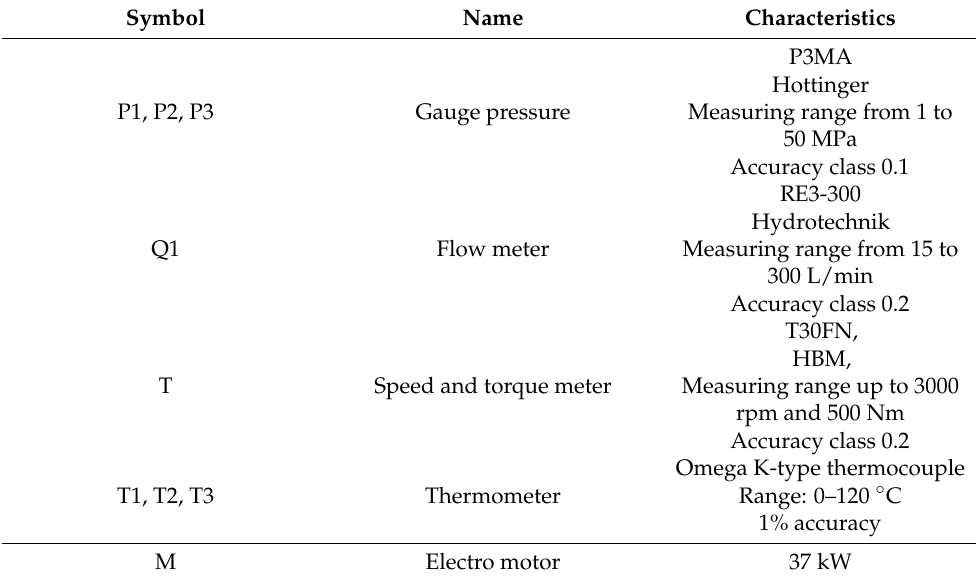
Table 1. Sensors and equipment used in the experimental test installation.